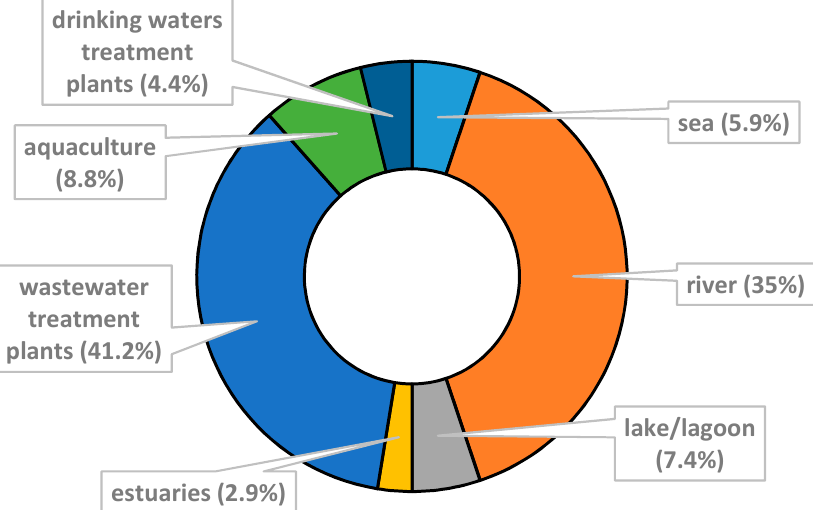
Figure 3. Proportions of studies (%) regarding population.